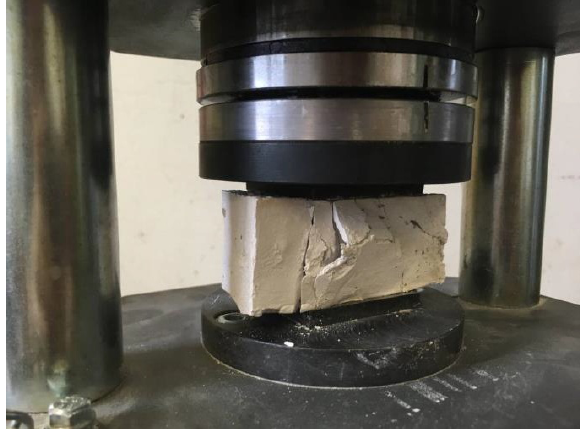
Figure 10. Compressive strength test